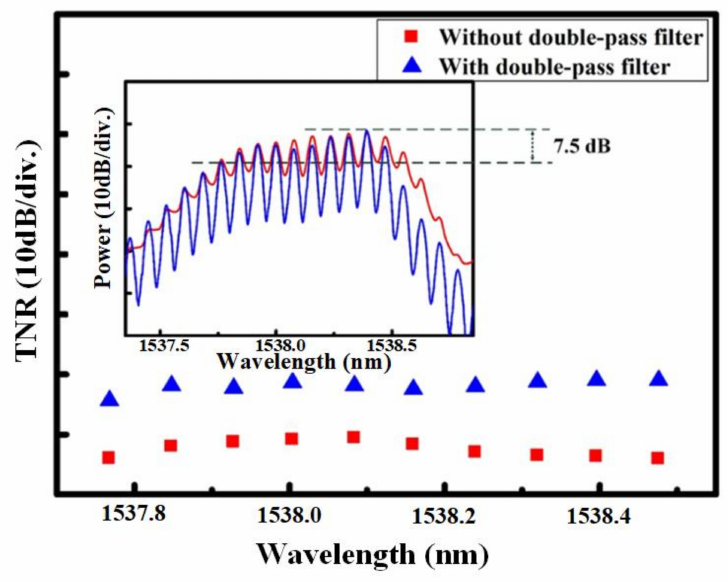
Figure 5. Output optical and TNR spectrum with and without a double-pass filter. The bit error rate (BER) curve and eye diagram of 155 Mbps and 622 Mbps signals after back-to-back (BTB) within 25 km SMF distance data transmissions are illustrated in Figure 8, where we selected only one wavelength optical spectrum of the multi-wavelength laser.